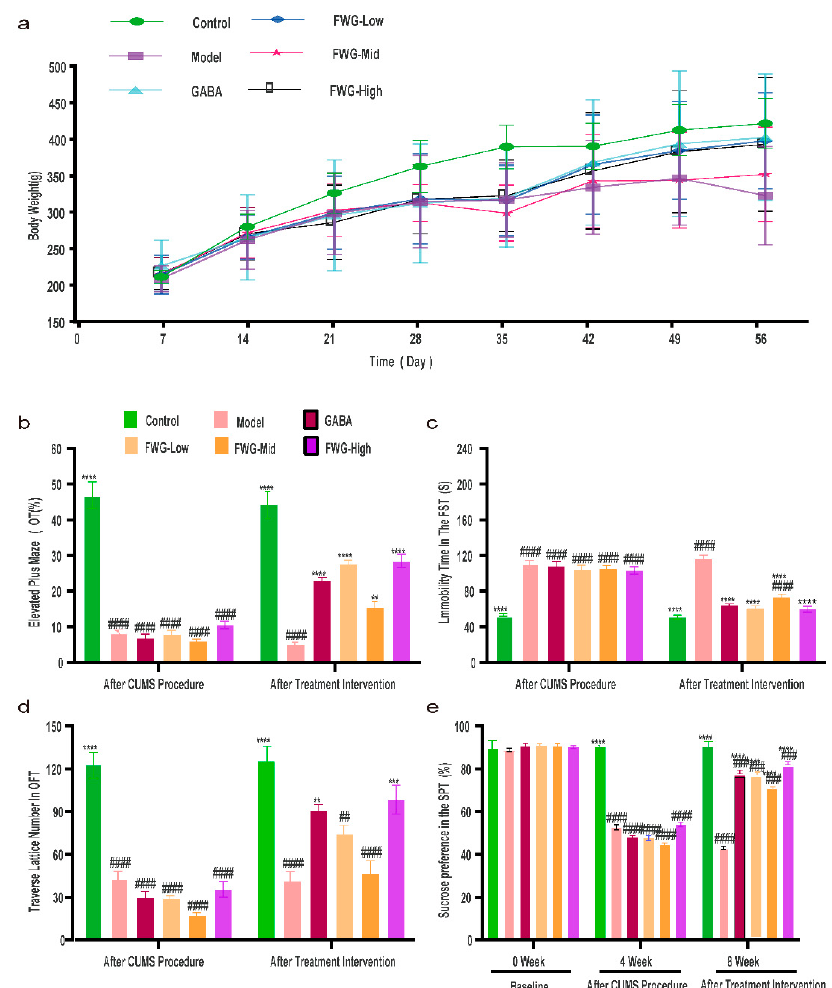
Figure 2. Effects of fermented wheat germ on the behavior of depressed rats. ( a ) Effect of FWG on body weight in CUMS rats. ( b ) Time to open arm as a percentage of total time (OT%). ( c ) Effect of fermented wheat germ on the immobility time of depressed rats in FST. ( d ) Number of lattices traversed by rats in OFT. ( e ) Effect of fermented wheat germ on sucrose preference in SPT. (** p < 0.01, *** p < 0.001, and **** p < 0.0001 indicate an appreciable difference compared to the model group. ## p < 0.01, ### p < 0.001, and #### p < 0.0001 represent that the difference was appreciable in contrast with the normal control group. N.S: statistically insignificant.)